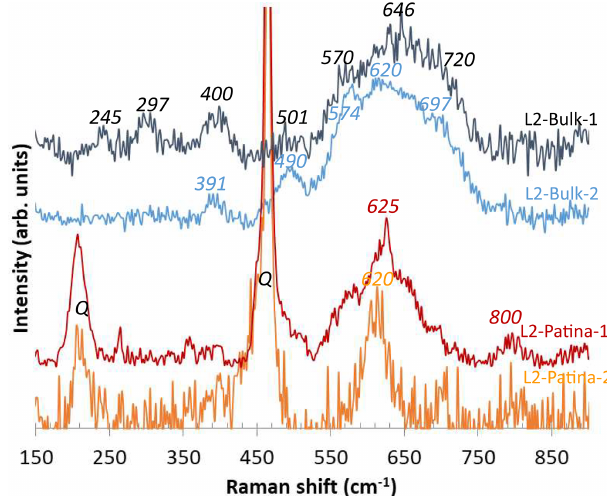
Figure 8. Representative Raman spectra obtained for Mn-rich phases from L2 bulk and patina. Q indicates quartz